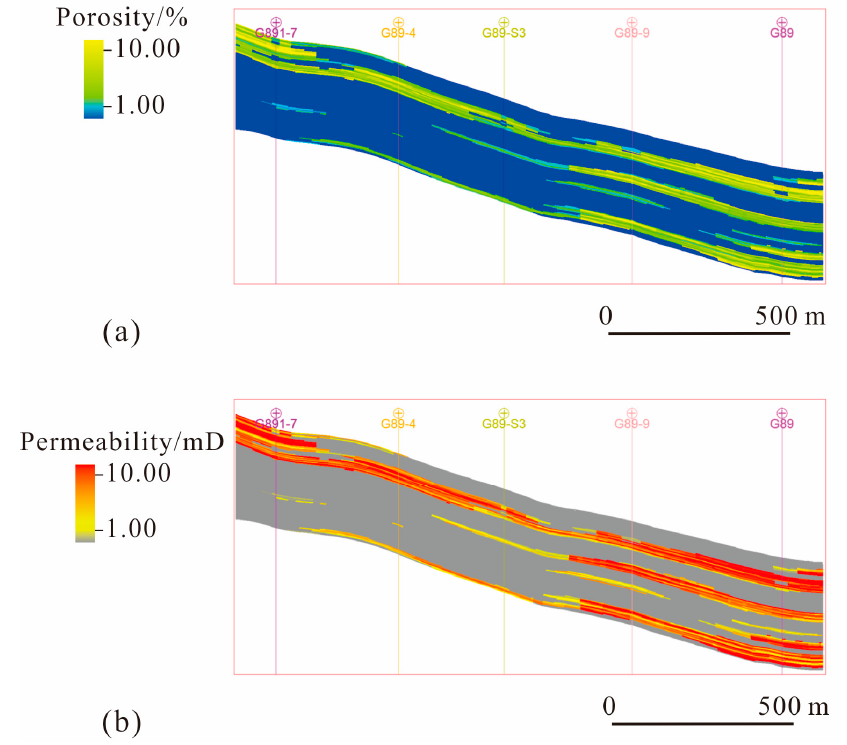
Figure 19. Cross sections of property models in the nearly north-south direction (see Figure 16 for the section location). ( a ) Porosity model; ( b ) permeability